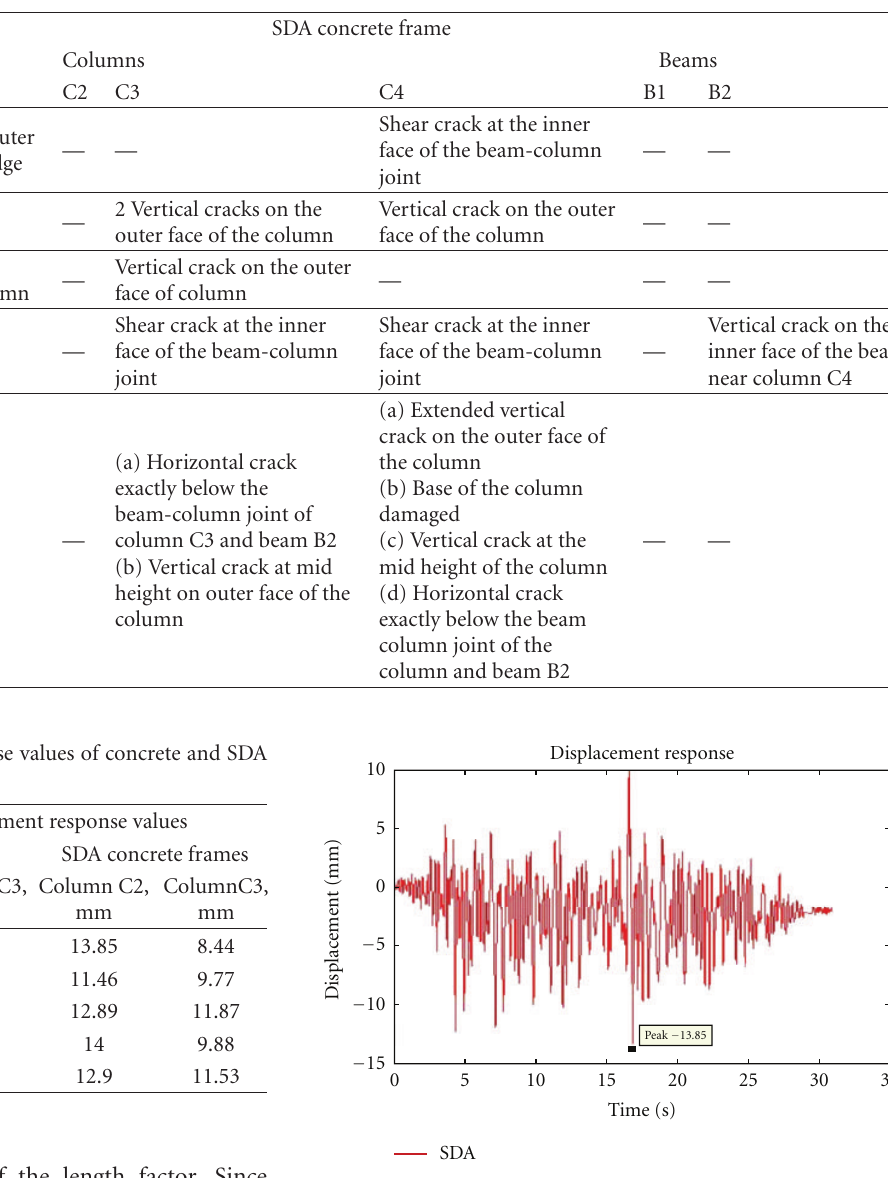
Figure 12: Displacement response of SDA concrete frame, column after test sequence